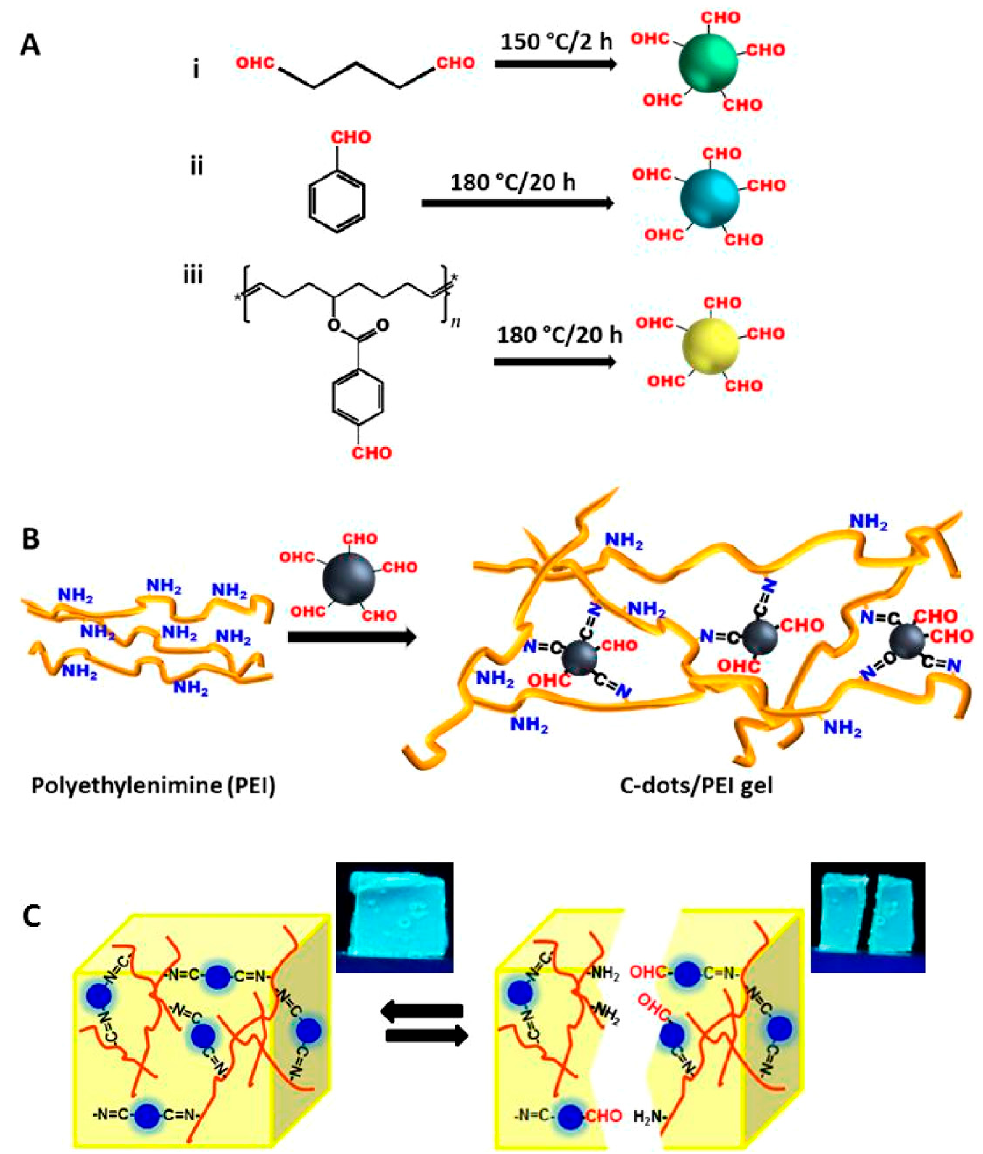
Figure 3. Preparation of the aldehyde-CD/PEI gels. ( A ) Preparation of aldehyde-CDs derived from an aliphatic dialdehyde (glutaraldehyde, i), aromatic aldehyde (benzaldehyde, ii), and cyclooctadiene-aldehyde polymer (iii). ( B ) Interaction of the CD/PEI gel via Schiff base reaction. ( C ) Self-healing characters of the gel were achieved via reversible imine-bond formation. FL images of the self-healing event are depicted. Reprinted with permission from [103]. Copyright (2019) American Chemical Society.